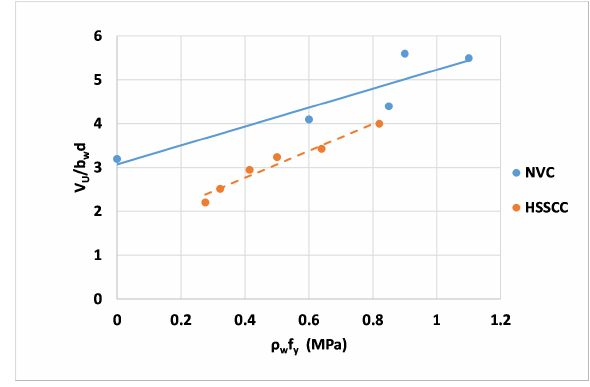
Fig. 7. Ultimate shear stresses of HSSCC and NVC beams gular section of width-150 mm, overall depth-450 mm and effective depth-405 mm with tension steel reinforcement of about 2.6%. ρ w f y was in between 0 to 1.16 MPa with shear span to depth ratio of